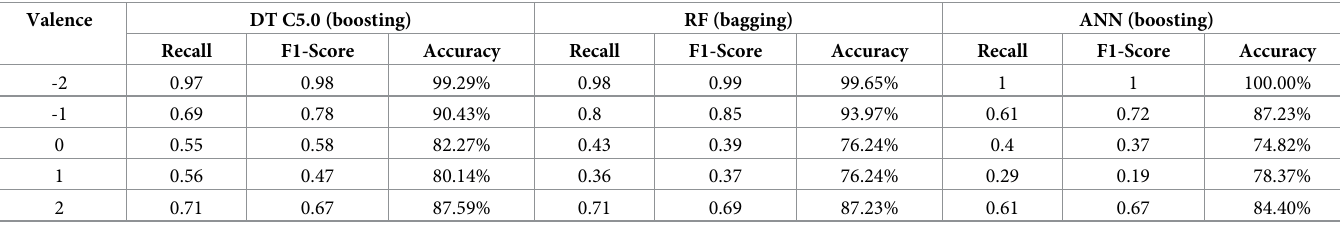
Table 12. Performance indexes of each class classification in the quinary classification model with ensemble learning. Valence DT C5.0 (boosting)